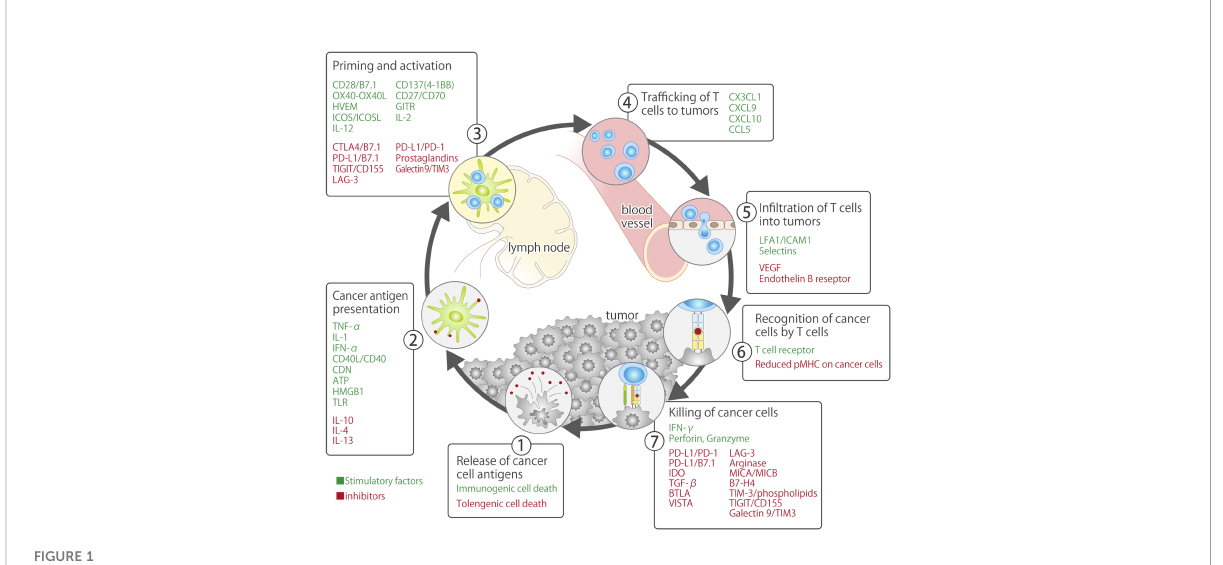
FIGURE 1 Cancer-immunity cycle and immune-checkpoint overview (8, 10 – 12).